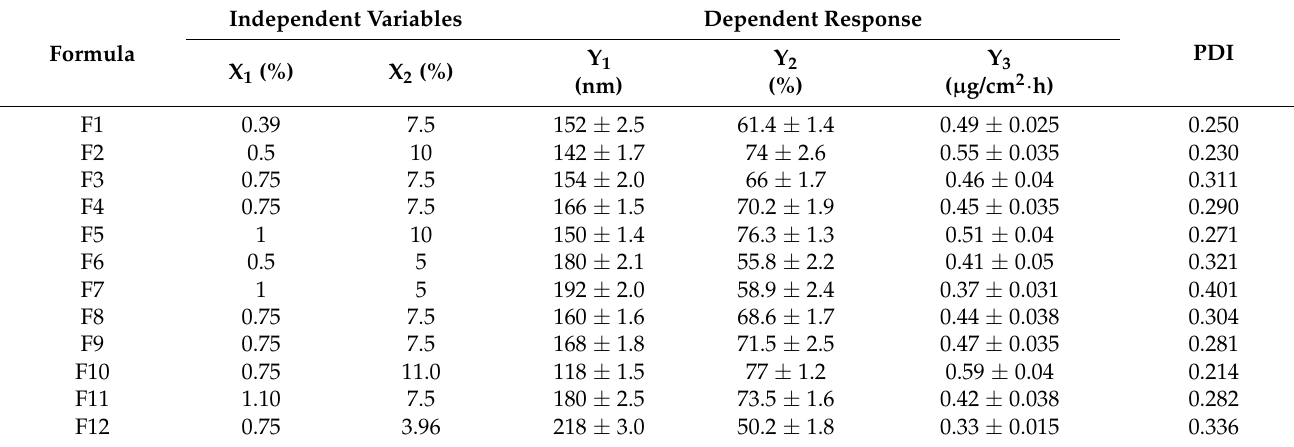
Table 1. Composition of various ethosomal formulations based on the experimental design and the resultant values of observed response.